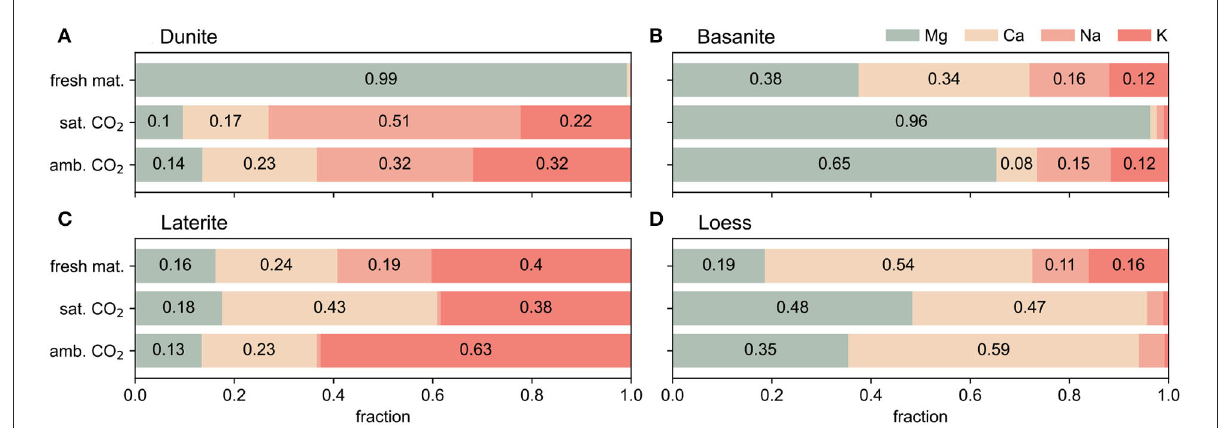
*HighK-fractioninthelateriteisassumedtobefromhighlysolublefertilizercontainedintheoriginalsoil.